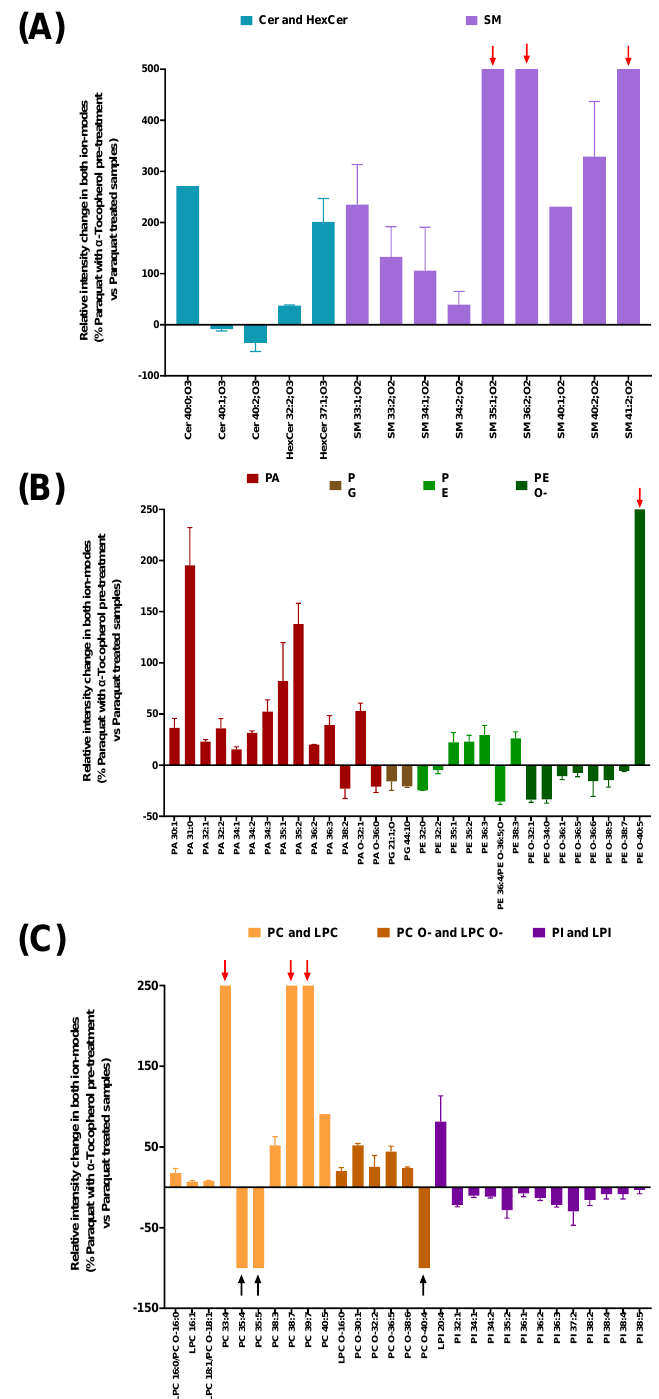
Figure 3. Relative intensity change in lipid adducts when comparing Paraquat-treated membranes preceded by an α -tocopherol pre-treatment with samples treated with Paraquat only. Data are shown as percentage of control values. ( A ) Change in sphingolipids (Cer, HexCer and SM). ( B , C )) Changes in glycerophospholipids. PA, PG, PE, and PE O shown in ( B ). PC, PC O-, LPC, LPC O-, PI, and LPI shown in ( C ). Abbreviations: Ceramides (Cer), hexosylceramides (HexCer), spingomyelins (SM), glycerophosphatidic acid (PA), glycerophosphoethanolamine (PE), glycerophosphoglycerols (PG), glycerophosphocholines and lysophosphocholines (PC and LPC), glycerophosphoinositols and lysophosphoinositols (PI and LPI). Ether forms indicated by the O-suffix. Oxygen number inside lipid head and fatty acids in Ceramides and Sphingomyelins is indicated by O with a